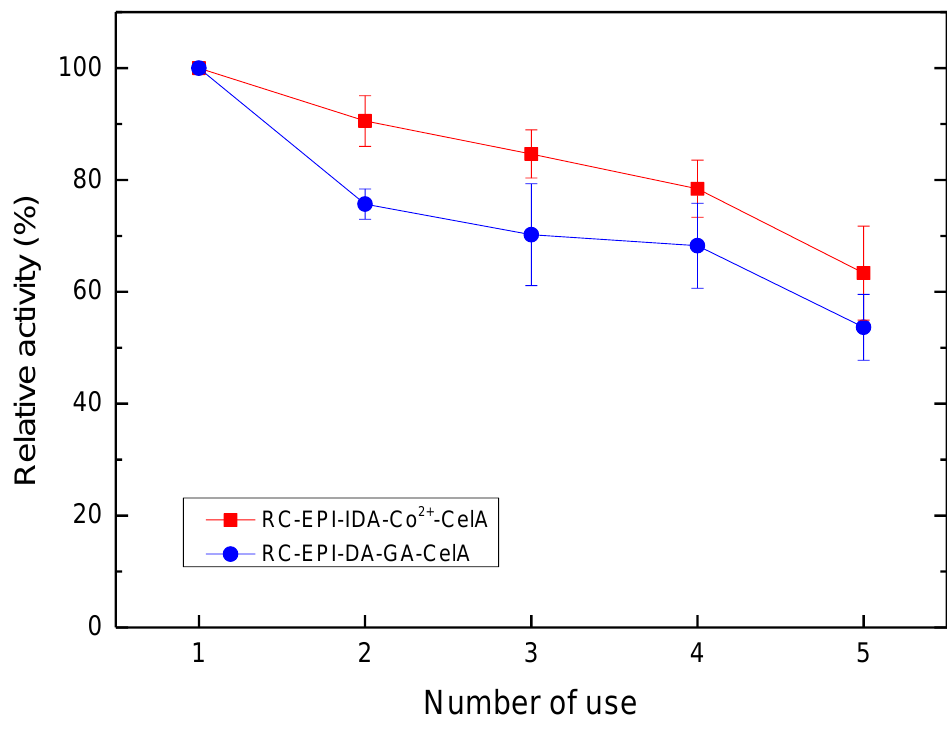
Figure 9. Reusability of RC-EPI-IDA-Co 2+ -CelA and RC-EPI-DA-GA-CelA enzymes.